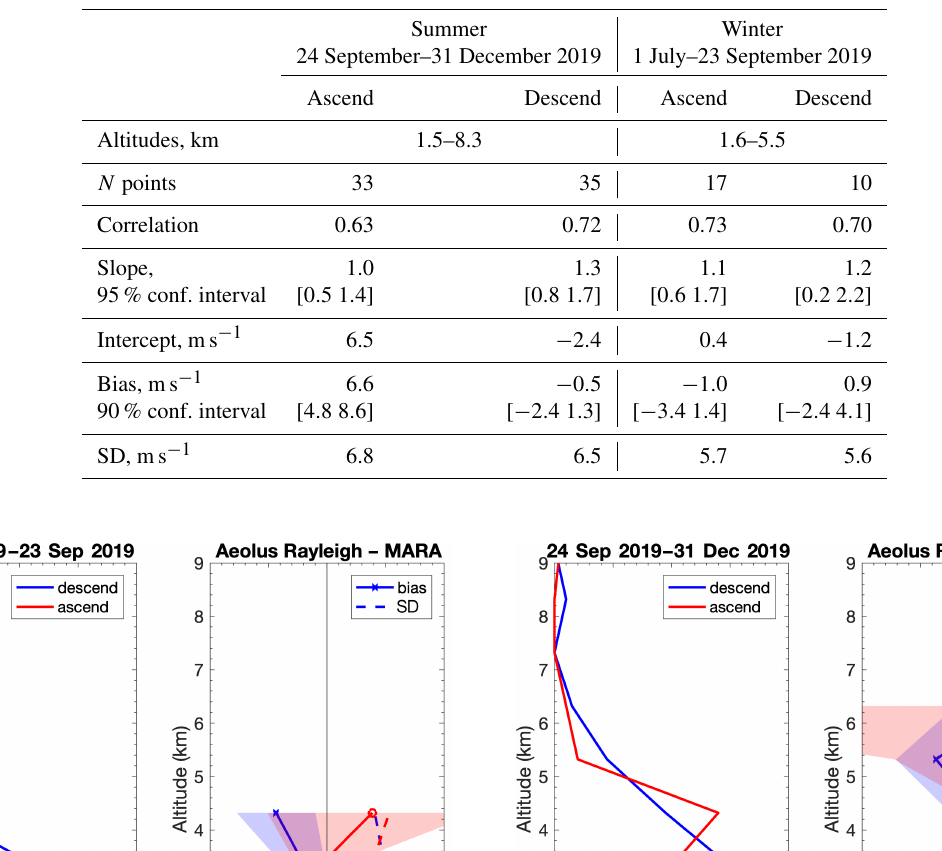
Table 3. Aeolus Mie–MARA HLOS wind comparison.